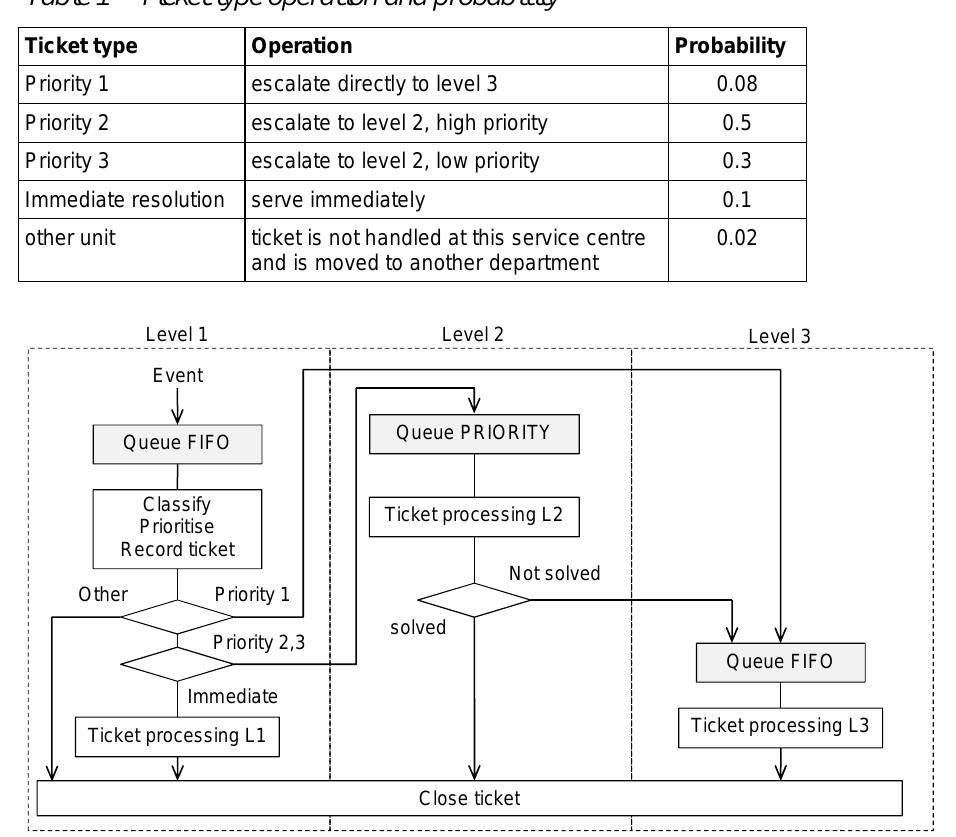
Figure 1 – Conceptual model of a service